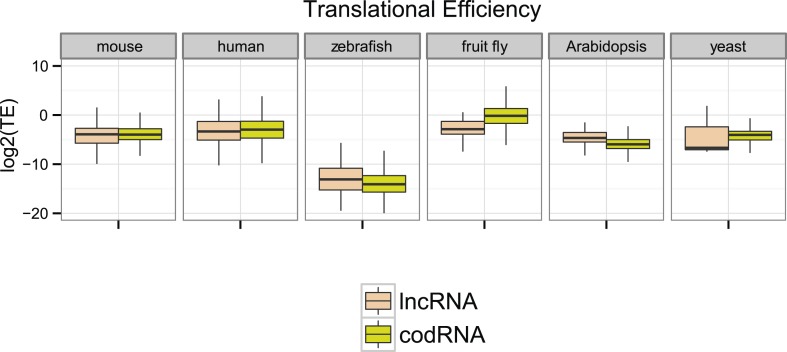
Ribosome association profiles for codRNAs and lncRNAs.Box-plots of transcript translational efficiency (TE) in log2(TE) units. The area within the box-plot comprises 50% of the data, and the line represents the median value. lncRNA: lncRNAs for which association with ribosomes was detected. codRNA: coding RNAs transcripts encoding experimentally validated proteins except for zebrafish in which all transcripts annotated as coding were considered.